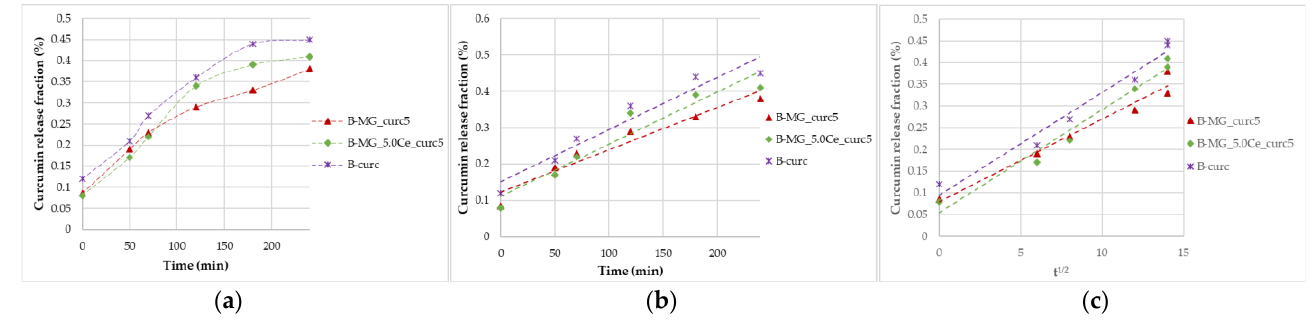
Figure 7. Curcumin release kinetics from B-MGs in SGF; ( a ) curcumin fraction released in the first 24 h for the samples B-MG_curc5 and B-MG_5.0Ce_curc5, and B-curc; ( b ) linearization according to Peppas’ model ( n = 1); and ( c ) linearization according to Higuchi’s mo del.